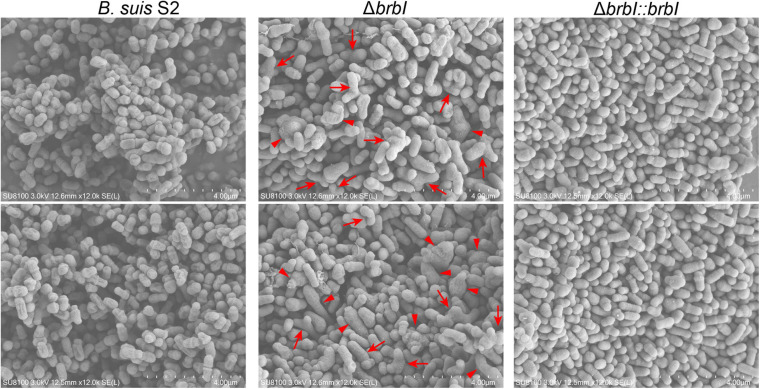
SEM analysis of the ΔbrbI strain. The B. suis S2 strain displayed a typical coccobacillus morphology (short-rod). The morphology of the ΔbrbI strain was aberrant, and manifested as Y-shaped or branched (arrows), intumesced or elongated bacterial cells (triangles), and fused bacterial cells (star). brbI complementation reversed the morphological irregularities. Bar = 4.00 μm.